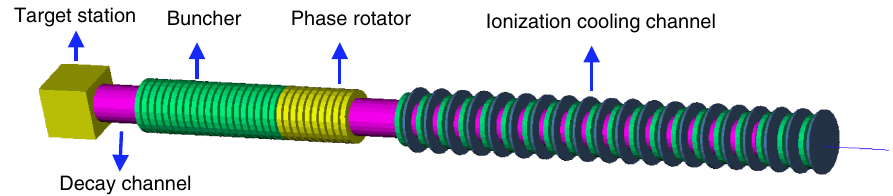
FIG. 1. Layout of the muon accelerator front